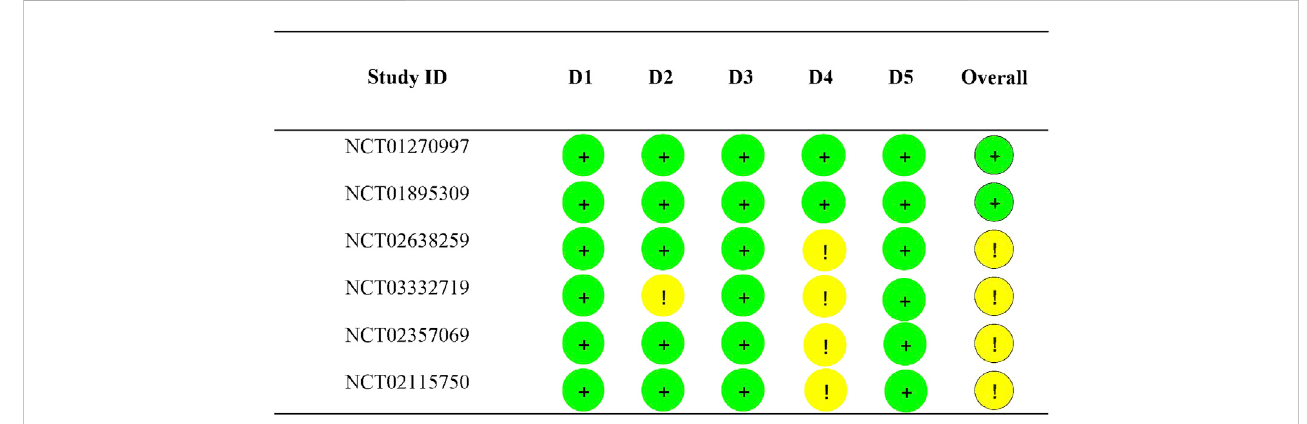
FIGURE 2 Risk of bias assessment results. D1: Randomization process; D2: Deviations from the intended interventions; D3: Missing outcome data; D4: Measurement of the outcome; D5: Selection of the reported results; + represents low risk; ! represents some concerns.